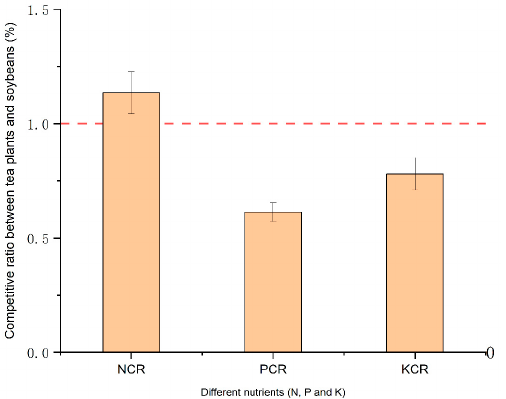
Figure 2. Competitive ratio for nitrogen, phosphorus and potassium in the tea plant/soybean intercropping system. The dashed line indicates the mean ( n = 3) value of XCR = 1.